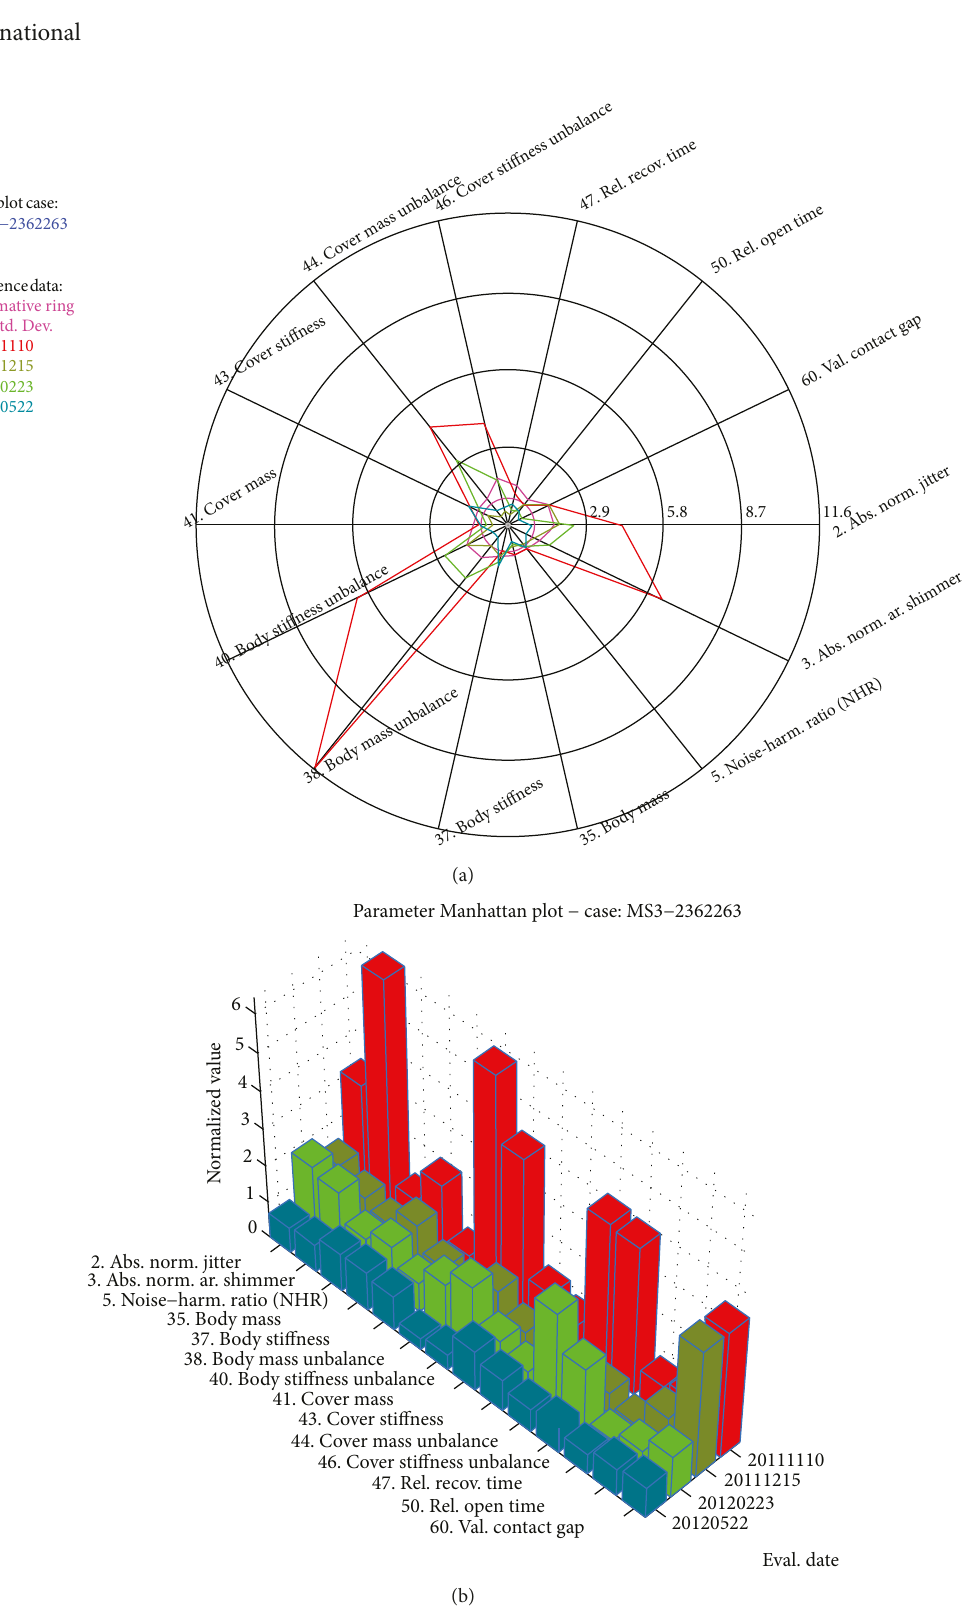
Figure 2: (a) Web plot of the longitudinal study. The evolution of the 14 parameters selected is shown chronologically from red (pre) to dark blue (post). Each normalized feature must be read on the intersection of each polygon with the corresponding feature radius. Clearly, features 2, 3, 35, 38, 40, 44, 46, and 60 are beyond the normality limits. (b) Manhattan skyline of the same study. Each feature from the four session recordings is presented chronologically from red to dark blue. The di ff erent features are now presented as polyhedral columns, the height of the column giving the normalized value of the feature relative to the population